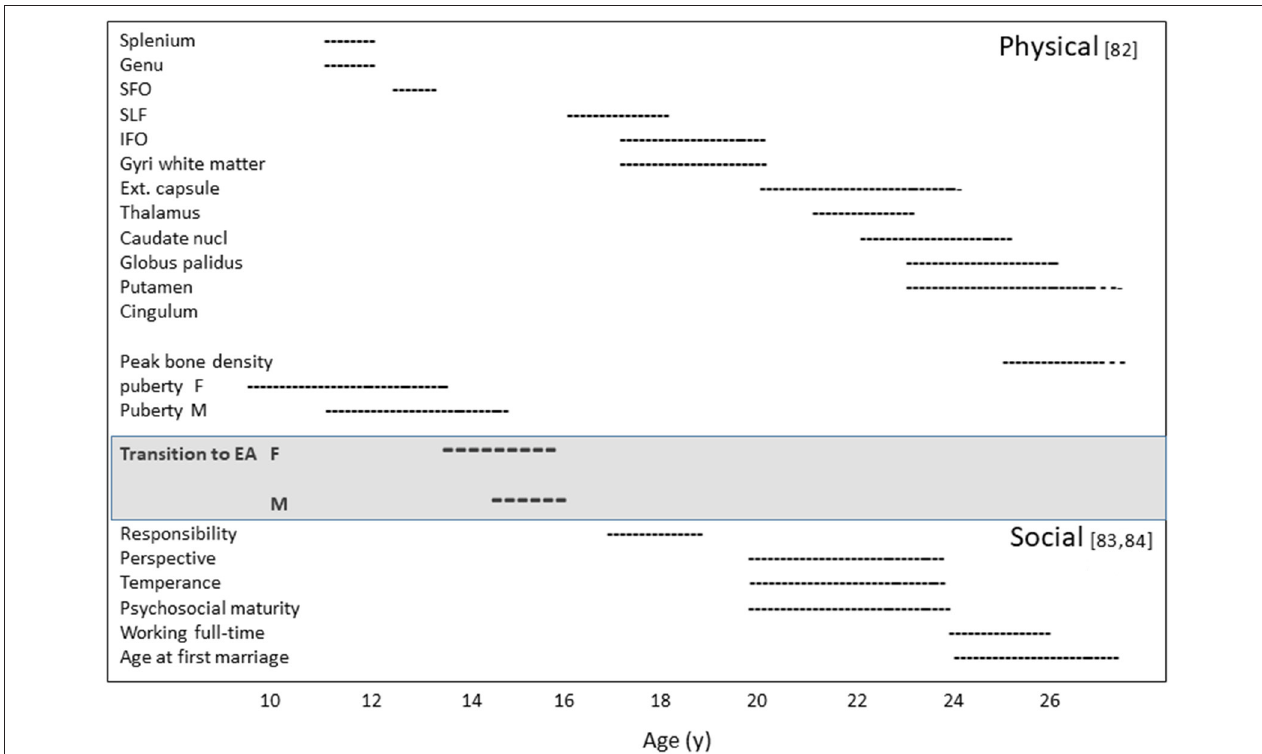
FIGURE 1 | Maturation timeline: (Upper) the age range to complete physical maturation (82). (Lower) the age range to complete social maturation (83) and US Bureau of Labor Statistics, 2014. SFO, The subfornical organ; SLF, The superior longitudinal fasciculus; IFO, anterior insula/frontal operculum complex; EA, emerging adulthood; F, female; M, male (